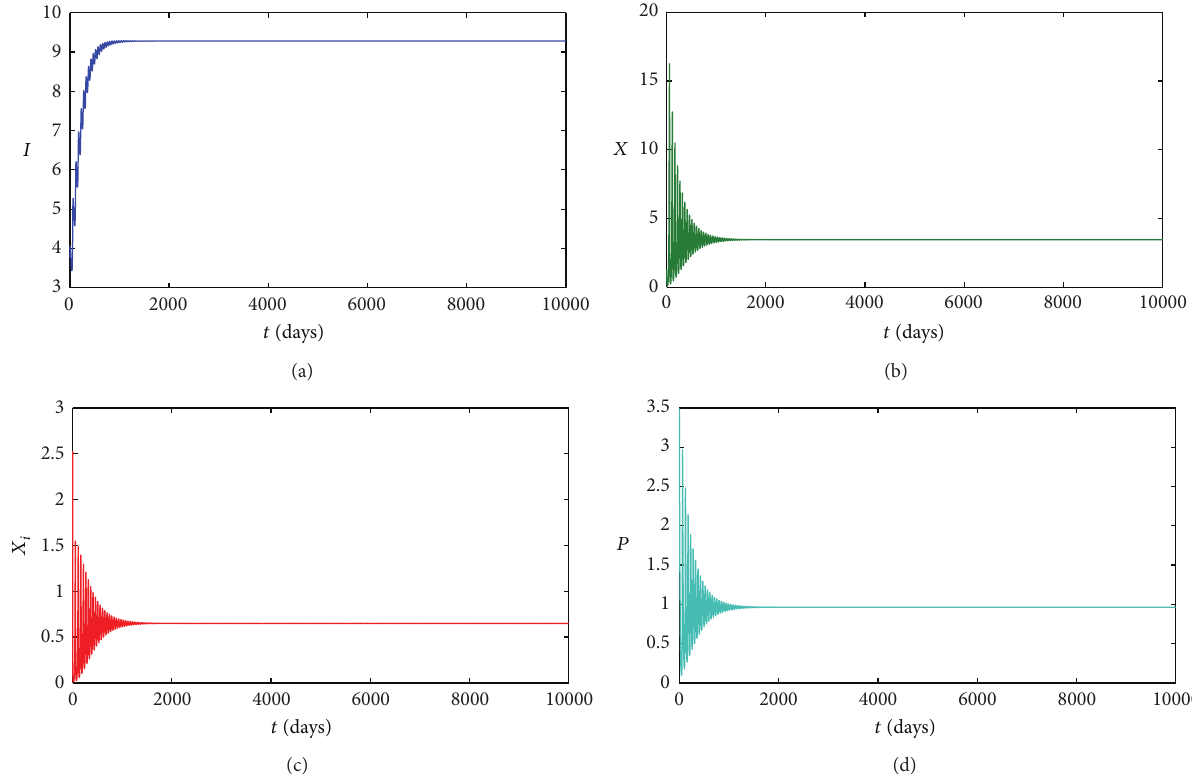
Figure 3: Numerical simulation for Case 1, with 𝑎 = 0.01 , ℎ = 0.2 , and other parameters fixed in Table 1. The vector-borne disease will persist though in presence of vector